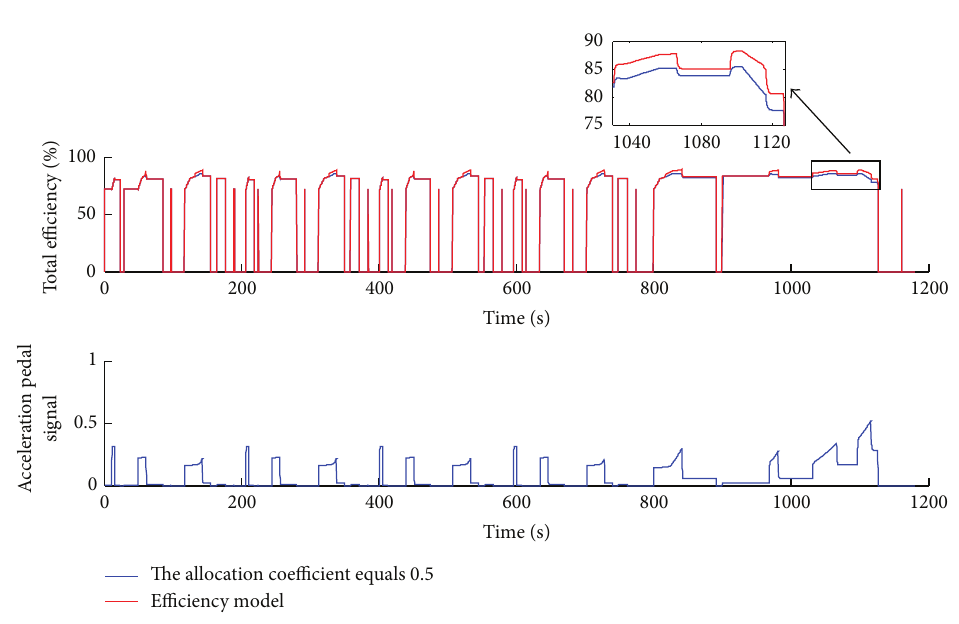
conditions. This paper sets the surface parameters at each wheel of different road surfaces as shown in Figure 19. The adhesion coefficients of high adhesion road, low adhesion, and uniform surface are constant and the coefficients of joint road represent an adhesion step change